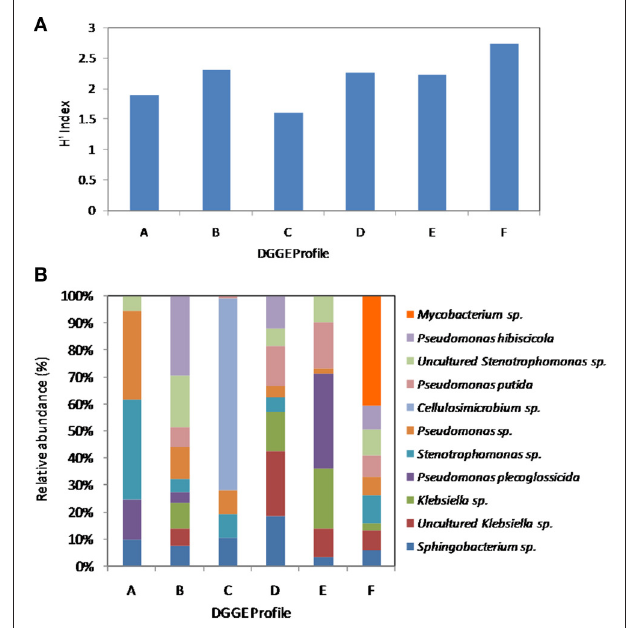
FIGURE 7 | Numerical analysis of the DGGE fingerprints revealing bacterial diversity among AK6 cultures grown on different sulfur sources. (A) Sulfur source-dependent change in the diversity index (H ′ ). (B) Species richness and abundance of various bacterial genera across the different AK6 bacterial communities. Glucose was provided as carbon source for all cultures and dibenzothiophene was also tested without glucose addition. A, benzothiophene; B 4,6-dimethyldibenzothiophene; C, dibenzothiophene (without glucose); D, dibenzothiophene; E, dibenzylsulfide; F,